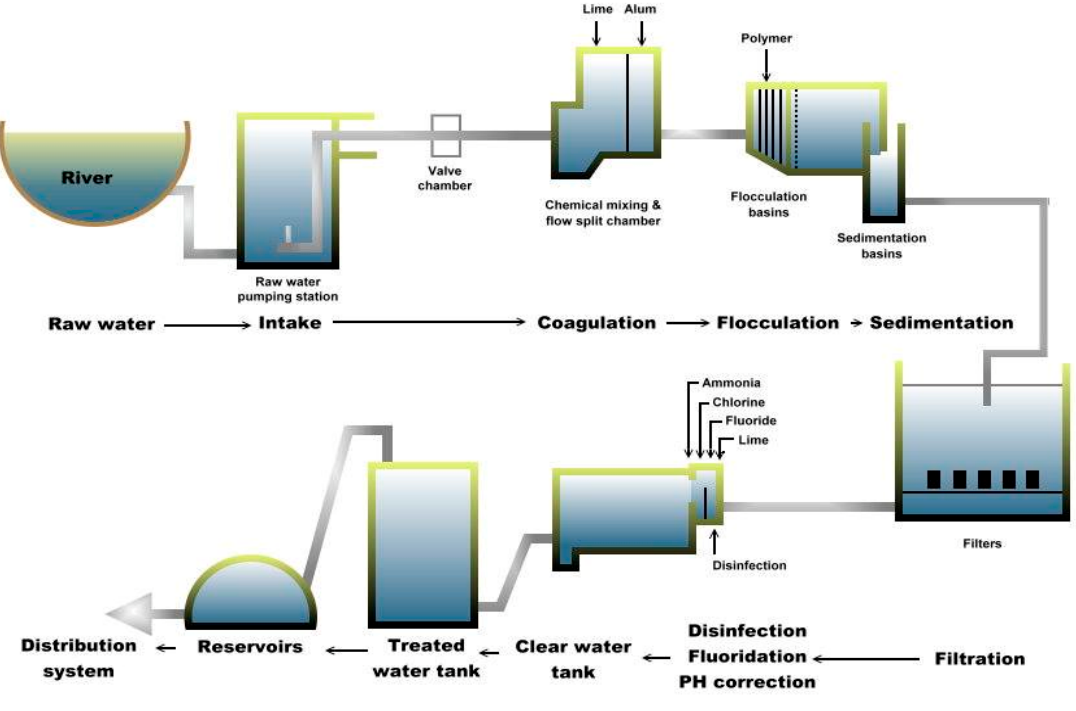
Figure 1. Schematic diagram of Plant A.